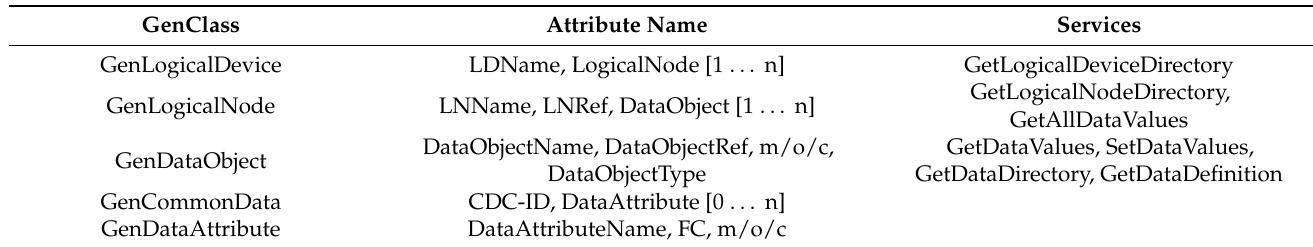
Table 1. Classes of IEC 61850 Information